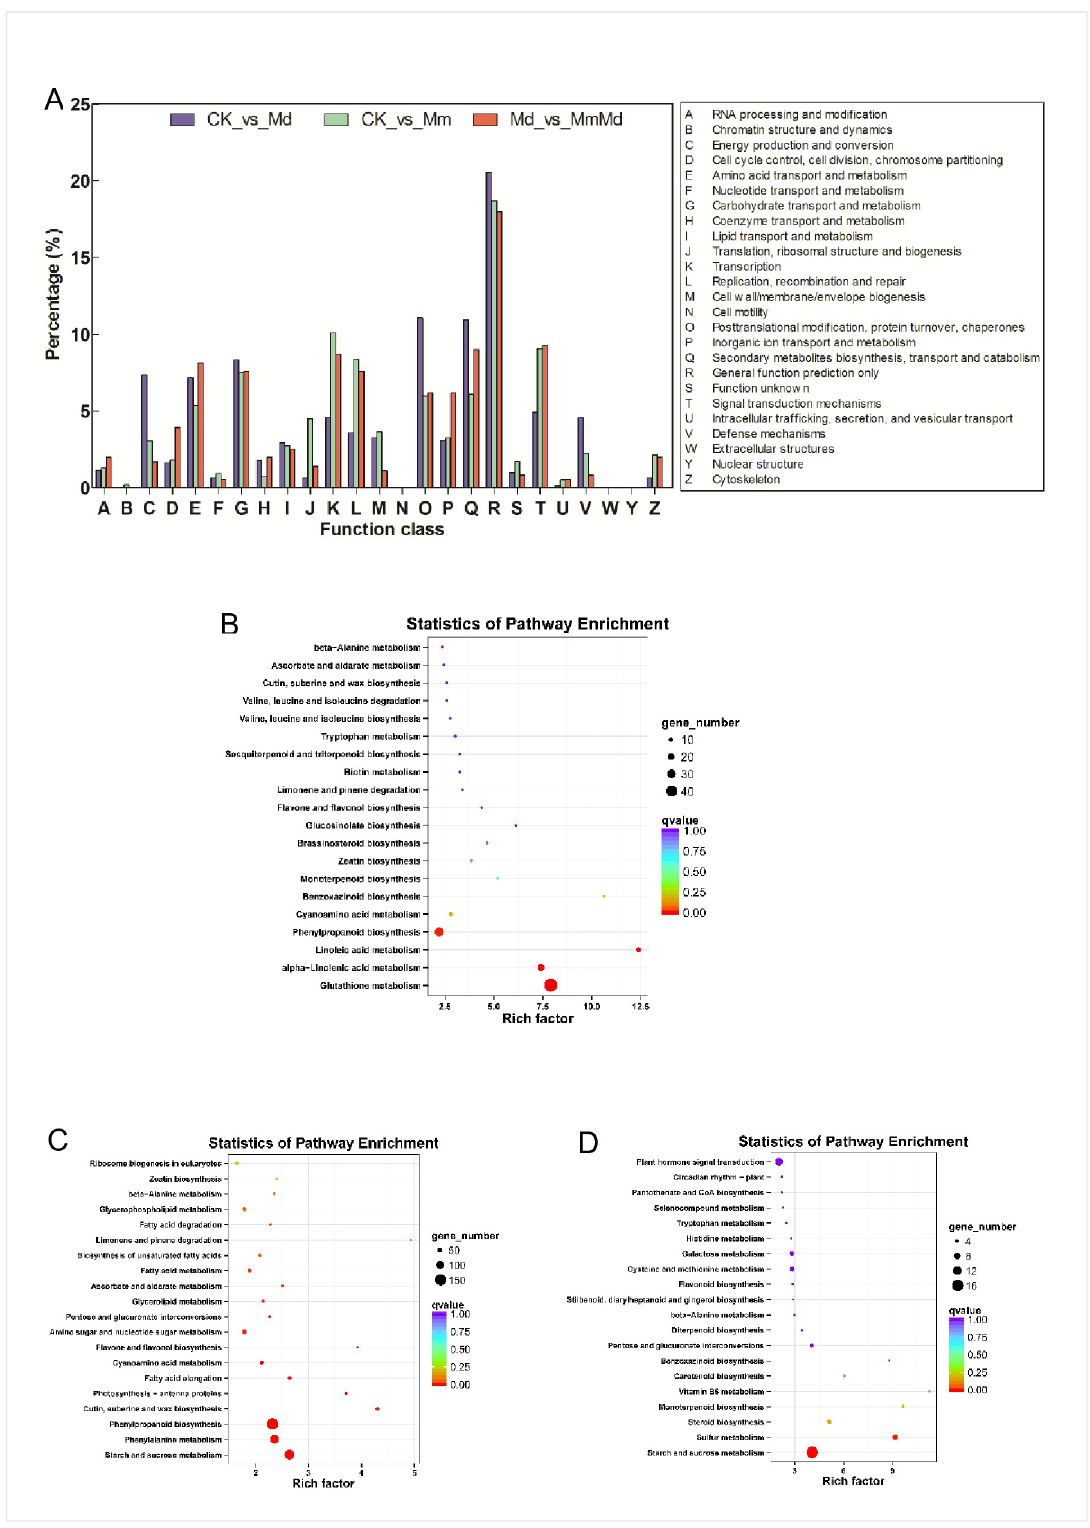
Fig 4. COG and KEGG enrichment analysis. COG annotation of differentially expressed genes (DEGs) between different groups (A). KEGG enrichment of DEGs in CK vs. Md (B), CK vs. Mm (C), and Md vs. MmMd (D).